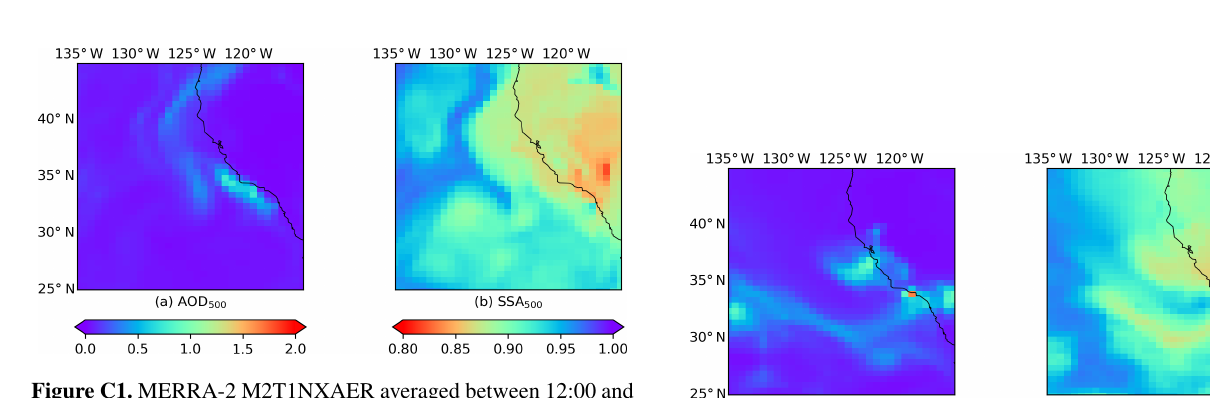
Figure C1. MERRA-2 M2T1NXAER averaged between 12:00 and 15:00LT for the Californian fire event on 12 December 2017: